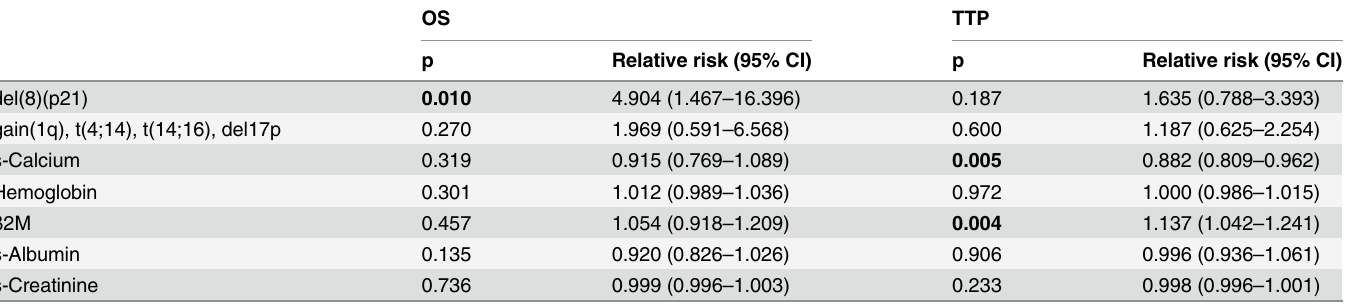
Table 2. Multivariate analysis of prognostic factors in multiple myeloma